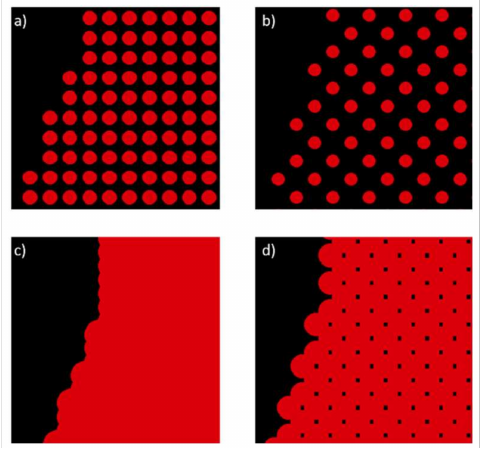
Figure 17. Output generated with “Inkraster” software: ( a ) drops do not connect, 100% coverage percentage; ( b ) drops do not connect, 50% coverage percentage; ( c ) drops connect, 100% coverage percentage; ( d ) drops connect, 50% coverage